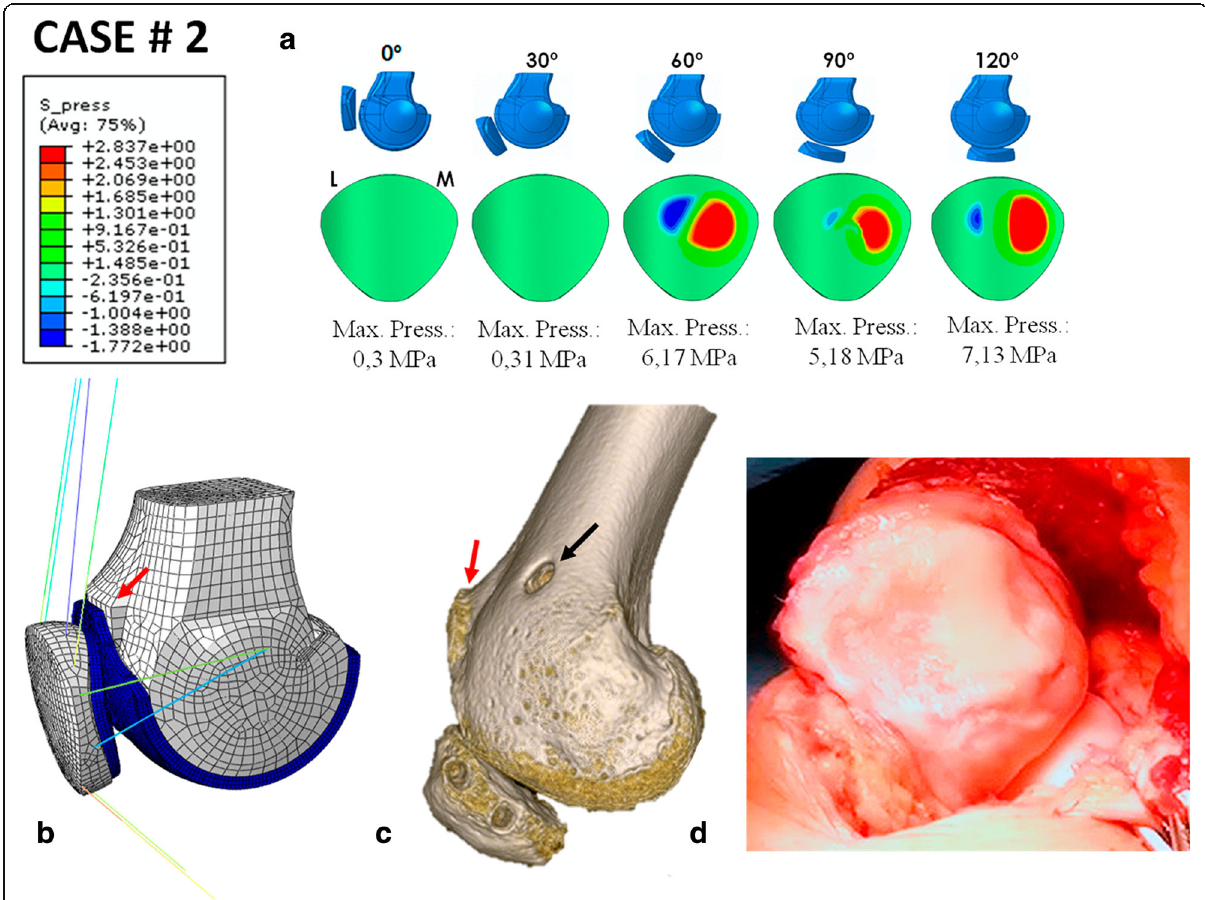
Fig. 5 Case # 2 Surgical failure: a Contact pressure (MPa) on the patellar cartilage L = Lateral M = Medial. b Parametric model of patient # 2. Trochlear dysplasia type D (red arrow). c Superior femoral attachment point is too far anterior (black arrow) Trochlear dysplasia (red arrow). d Visible patellofemoral